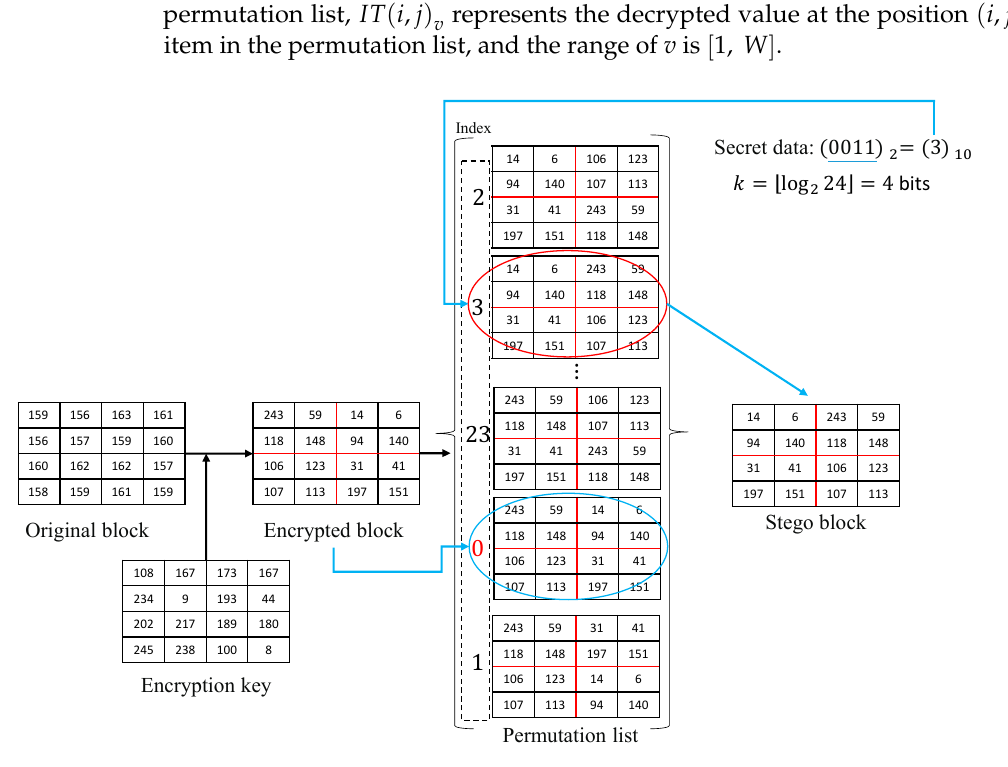
Figure 5. An example of the embedding process in which the 4 × 4 pixel block is divided into 4 sub- blocks.